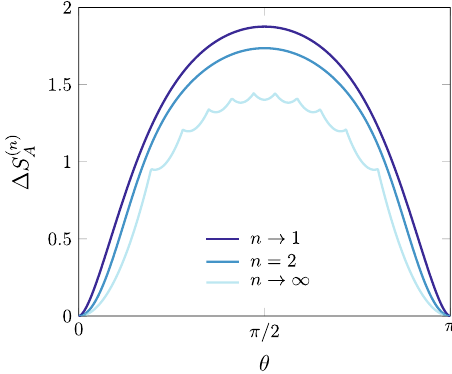
Fig.2|Rényientanglementasymmetry Δ S ð n Þ A forthetiltedferromagneticstate. We plot the analytic expression of Eq. (8) for this state as a function of the tilting angle θ for different values of the replica index n and subsystem size ℓ